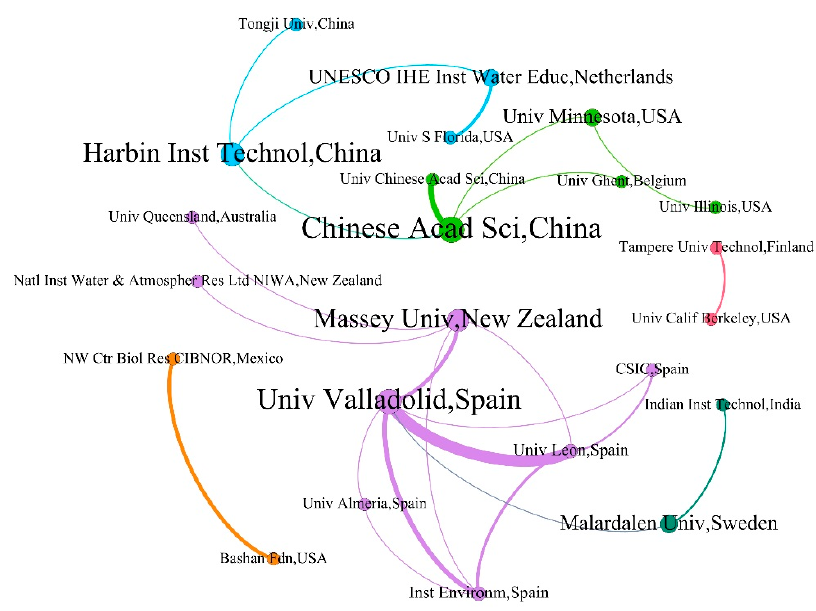
Figure 3. The academic collaborative relationships among the top 30 productive institutions.